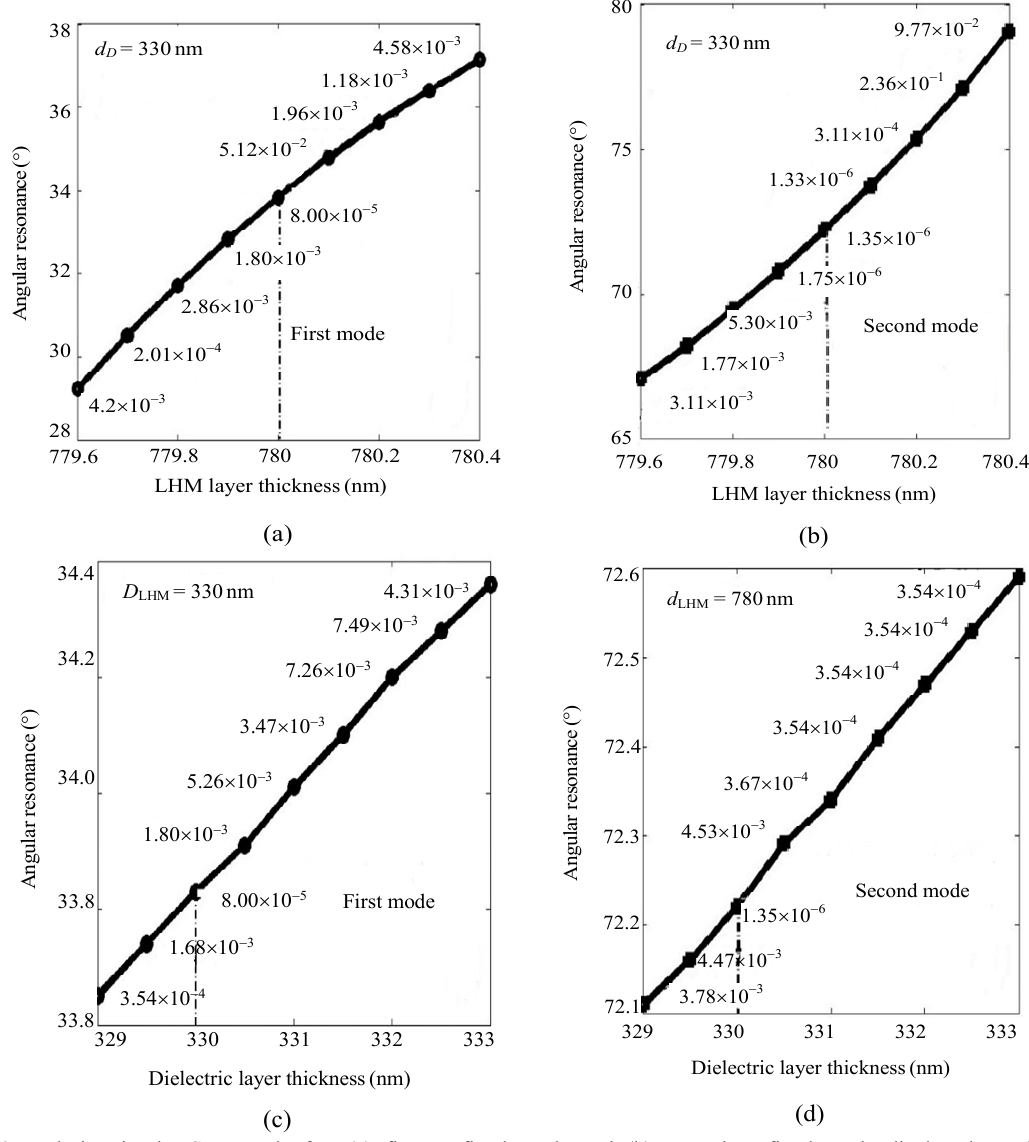
Fig. 6 Evolution in the SPR angle for: (a) first-confined mode and (b) second-confined mode displayed on the parallel under the change of LHM thickness with a fixed d D =330 nm, (c) first-confined mode, and enhancement factor f  under the change of dielectric gap with a fixed thickness, (d) second-confined mode displayed on the parallel enhancement factor f  d LHM =780